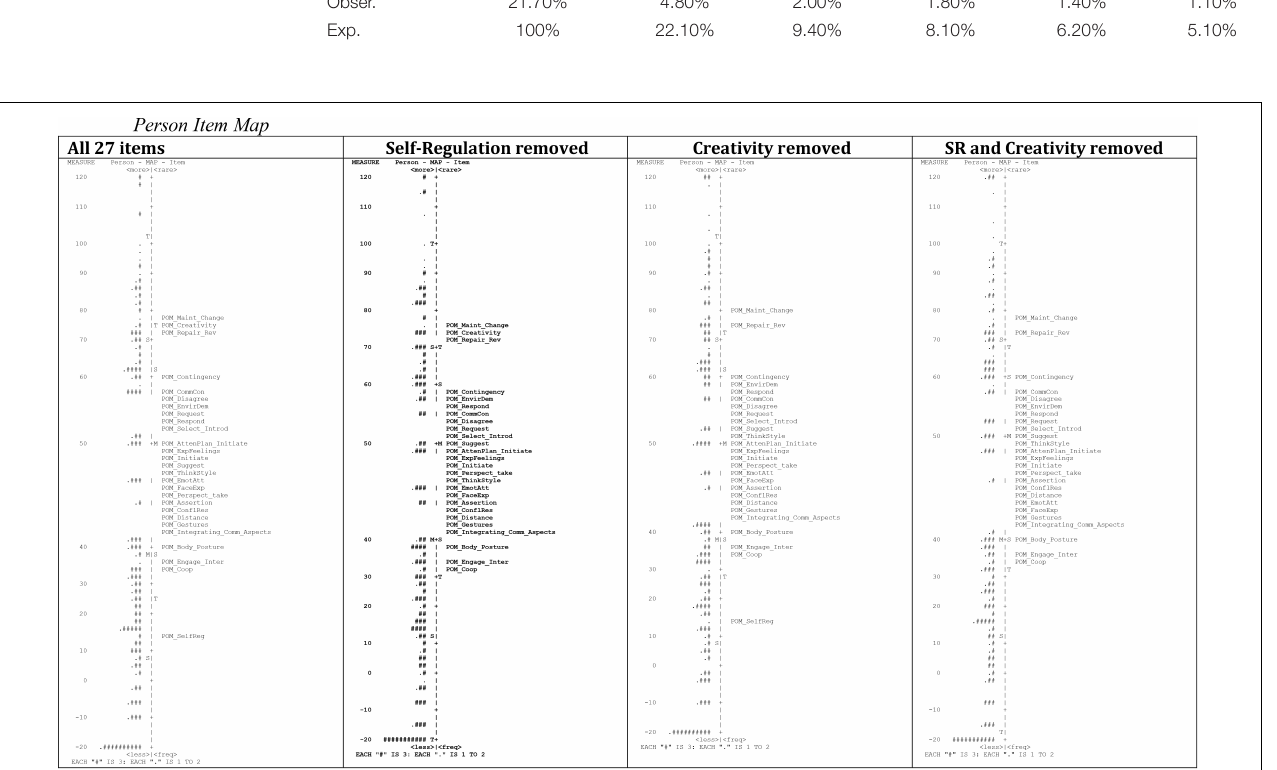
FIGURE 2 | Person item